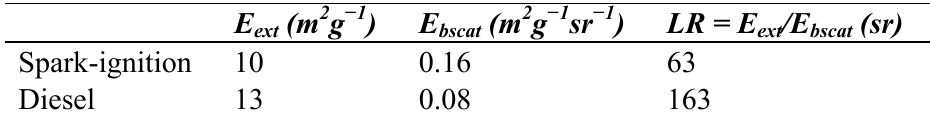
Table 1. Theoretical extinction and backscattering PM mass efficiencies for different engine